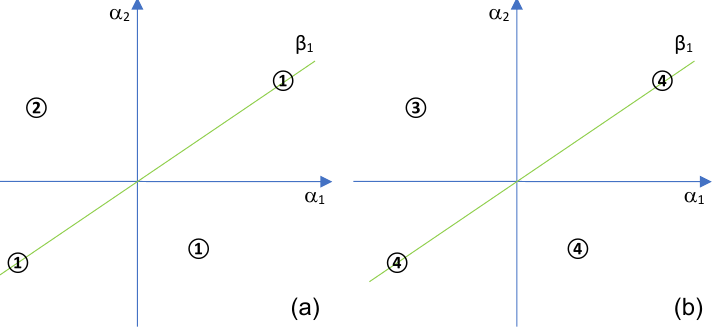
Figure 11. Bifurcation diagrams when p > 0 or ( p < 0 and r > 0): ( a ) a > 0, L 0 > 0, h < 0